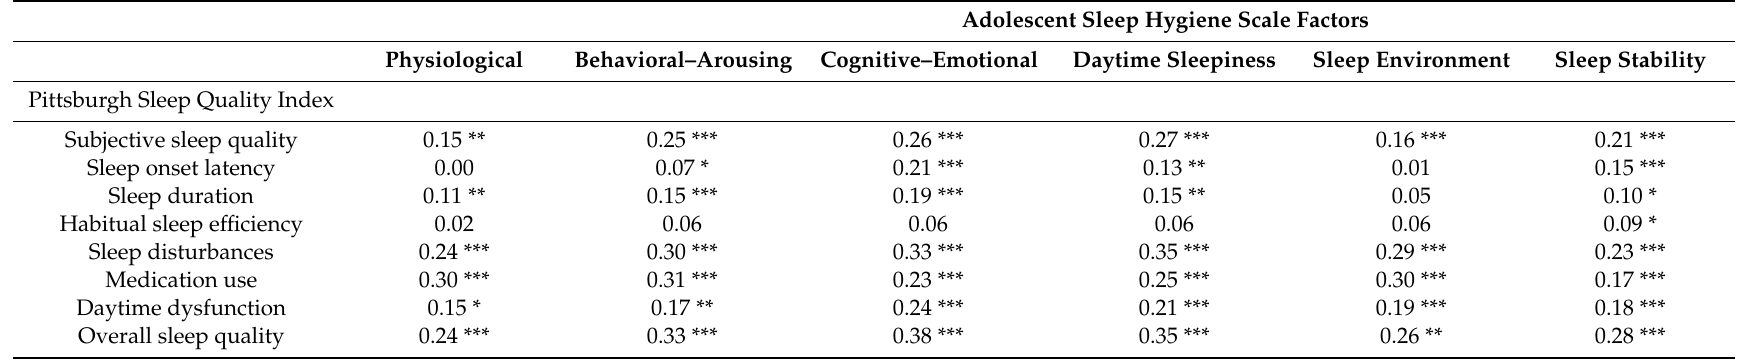
Table 3. Overview of the intercorrelations between the seven dimensions of the Pittsburgh Sleep Quality Index (PSQI); N =